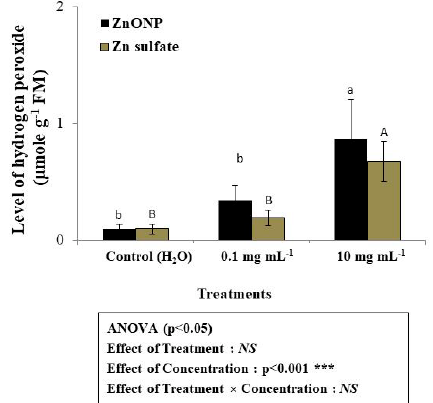
Fig. 5: Level of proxide hydrogen in the embryonic axes of Lathyrus sativa L. seeds germinated for 4 days in the presence of distilled water (Control) or solutions of ZnO NPs and ZnSO 4 of 0.1 mg ml -1 and 10 mg ml -1 . Values are means (±SD) of 5 independent measure- ments. Letters a-b and A-B denote statistic classes, respectively, for ZnO NPs and Zn sulfate, using Duncan test (α=0.05). Differences are significative, at *: 0.01≤P<0.05, **: 0.001≤P<0.01, ***: P<0.001, and non significant NS at P≥0.05.